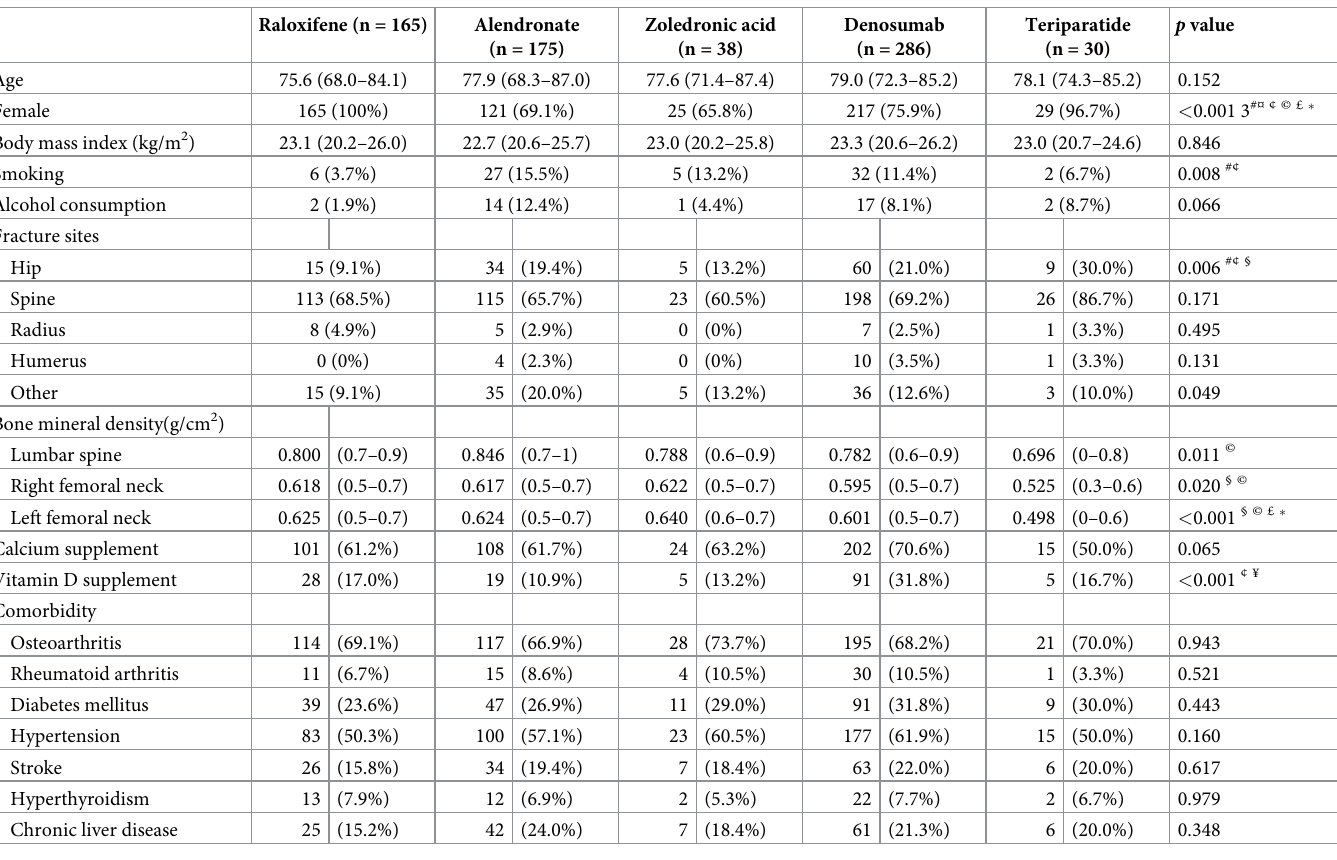
Table 1. Patient characteristics by discontinued anti-osteoporosis